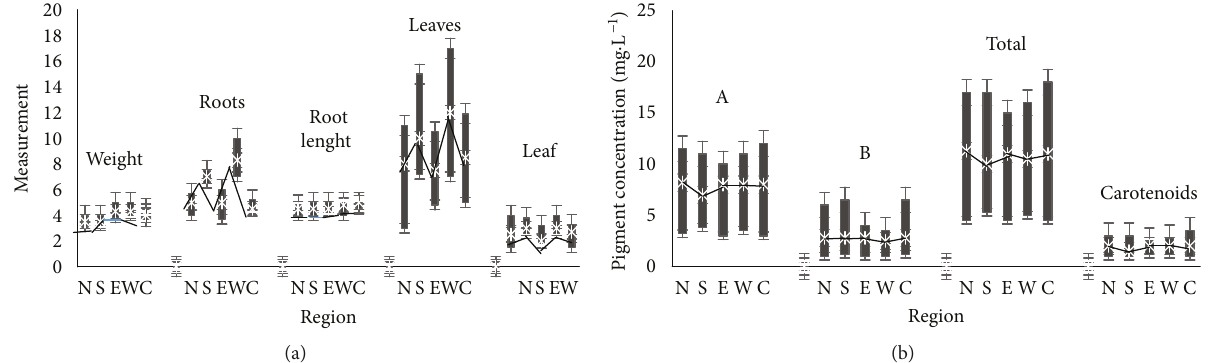
Figure 10: Willow tolerance (a) biomass parameters: weight (g), root number, root length (cm), leaf number, and leaf area (cm 2 ); (b) pigment concentration (mg · L − 1 ) from di ff erent regions: north (N), south (S), east (E), west (W), and center